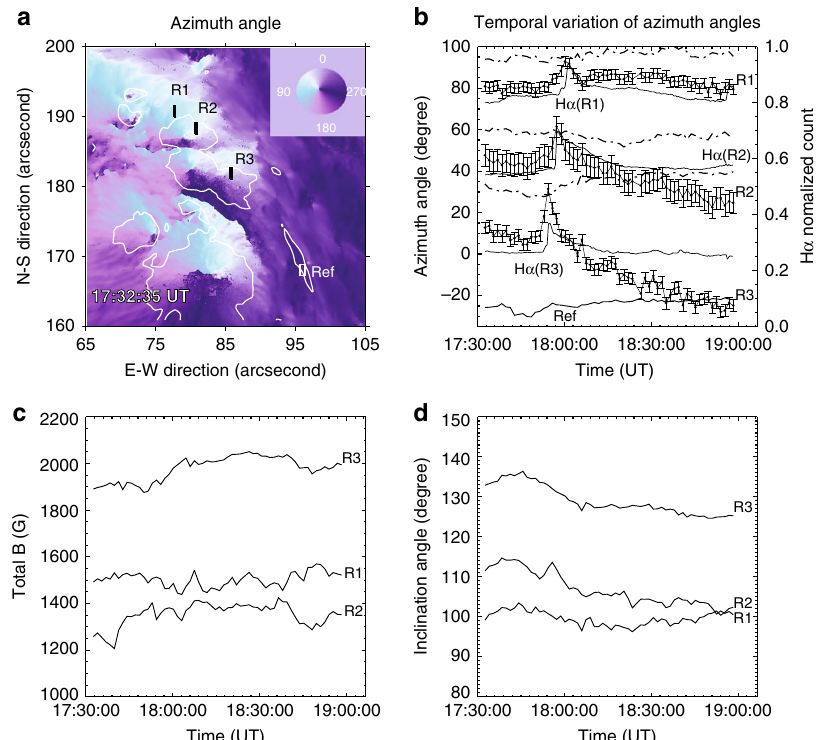
Fig. 3 Temporal evolution of azimuth angle deviation. a Azimuth angle map taken before the fl are at 17:32:35 UT. Three slits are put on the regions of interest (R1-3), plus a reference region in the lower right corner. The white contours outline the sunspot umbral areas ( > 1800 G). b The curves with error bars are the temporal variation of averaged azimuth angle within regions of R1-3. The uncertainties are estimated using the standard deviation of the pre fl are data points. The peaks are more than three times of the uncertainties rendering themselves statistically signi fi cant. The fl are time is determined by the H α light curve, for instance, the dashed line is the H α light curve of R3, in which the peak matches with azimuth angle peak in R3. All H α light curves are in natural log space and self-normalized to their peak emission. In the bottom, the temporal variation of the azimuth angle in the reference region is plotted, which is manually increased by 50° to match the plotting range (50 – 190°). The dotted-dash curves are the azimuth angles of extrapolated potential fi elds that remain certain levels above the azimuth angles of real fi elds. c Temporal variation of averaged magnetic fl ux strength within the representative areas.